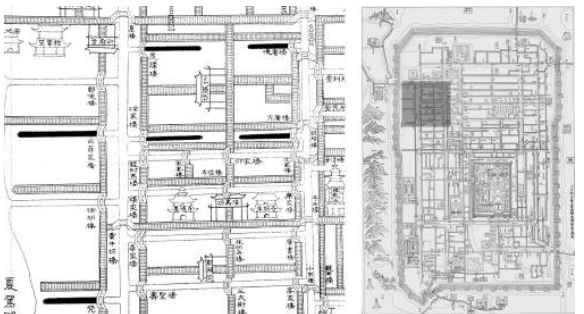
Figure 5 ． A part from the Map of Pingjiang showing canals without mark at the end （ bold black lines ）